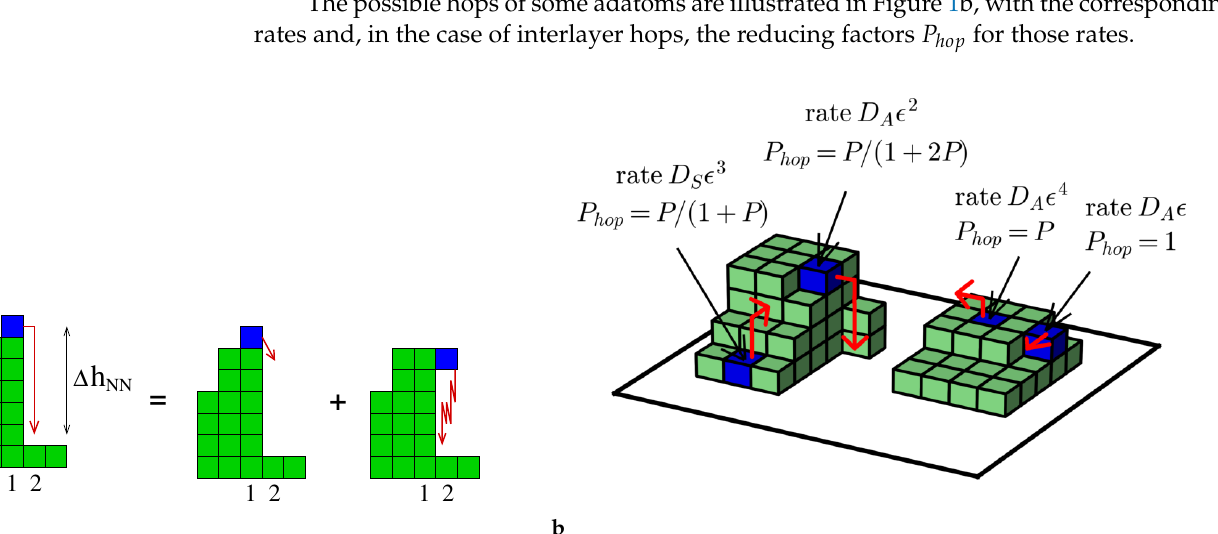
Figure 1. ( a ) Two-dimensional scheme of a hop (left) of an adatom (blue square) between the tops of columns 1 and 2. The hop in the model represents the crossing of the step edge (middle) plus the diffusion along a vertical wall (right). The other adatoms are in green color. ( b ) Hopping rates of four adatoms (blue cubes) and the probabilities of the hop attempts indicated by arrows